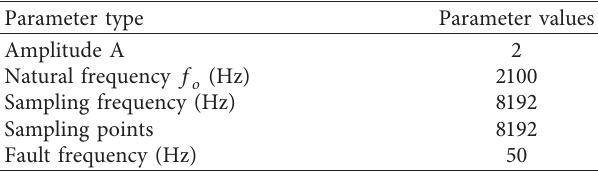
Table 1: Parameters of the simulated